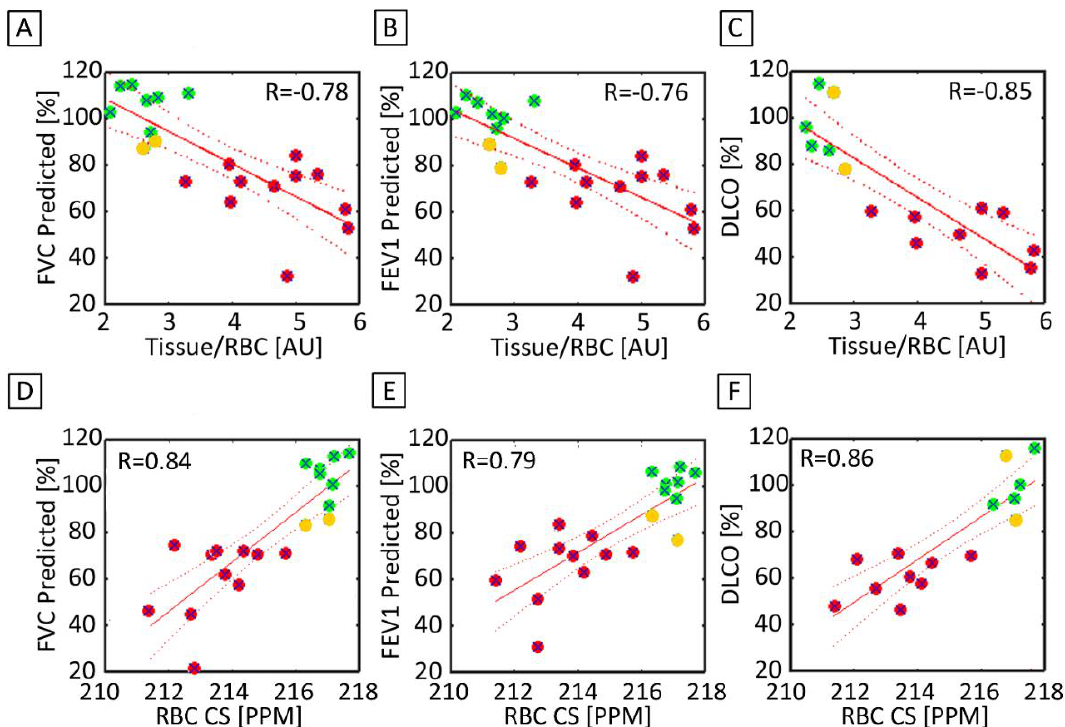
Figure 7. ( A ) FVC predicted and the Tissue/RBC ratio were significantly and strongly correlated between healthy (green), healthy but low PFT (yellow), and IPF (red) subjects (R = − 0.78). ( B ) There was also a significant strong correlation between FEV1 predicted and the Tissue/RBC ratio (R = − 0.76). ( C ) DLCO and the Tissue/RBC ratio (R = − 0.85) were also significantly strongly correlated. ( D ) FVC predicted and the RBC chemical shift were significantly correlated (R = 0.84). ( E ) There was another significant and strong correlation between FEV1 predicted and the RBC chemical shift (R = 0.79). ( F ) DLCO and the RBC Chemical Shift (R = 0.86) were also significantly correlated. The solid line represents a linear regression of the data, while the dashed lines shows the 95% confidence interval of the linear regression.